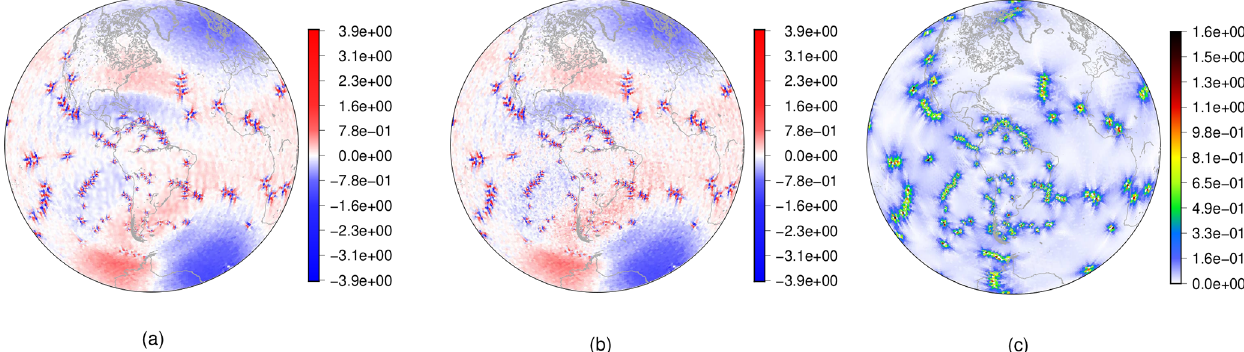
Figure 6. (a) Height field error using a constant hyperdiffusion coefficient and a (b) diameter-based hyperdiffusion coefficient for the steady geostrophic flow test case considering a VR6 grid at day 30 and K max = 10 13 m 4 s − 1 (see Sect. 4.1). (c) Alignment index (Peixoto and Barros, 2013) for the VR6